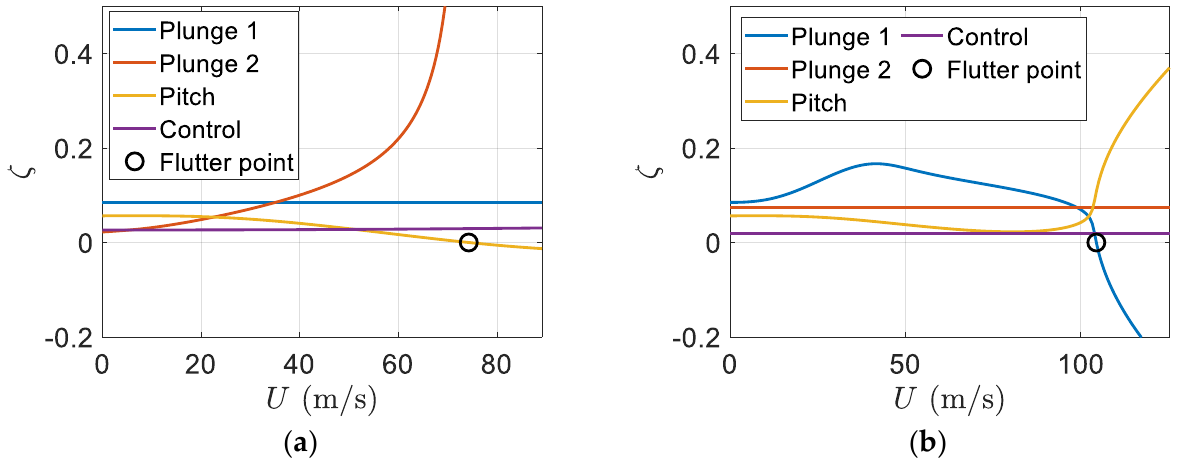
Figure 16. The smart blade damping ratio versus airspeed with plunge piezopatches ( a ) and plunge and pitch piezopatches ( b ).